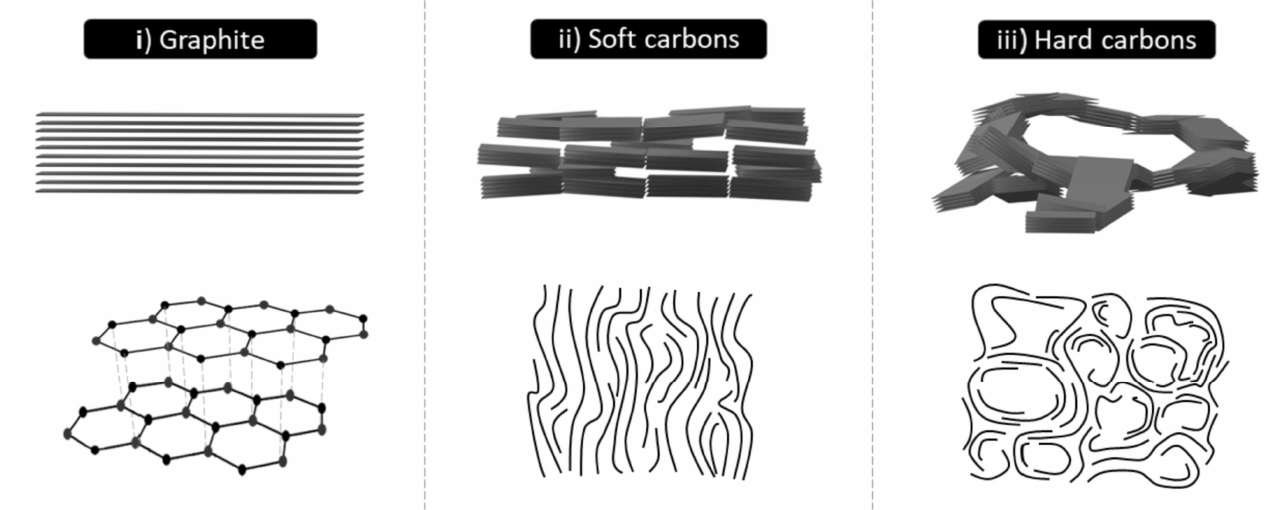
Figure 2. Schematic structures of Gr, soft carbon, and hard carbon. Reproduced from [19] with permission from Elsevier.